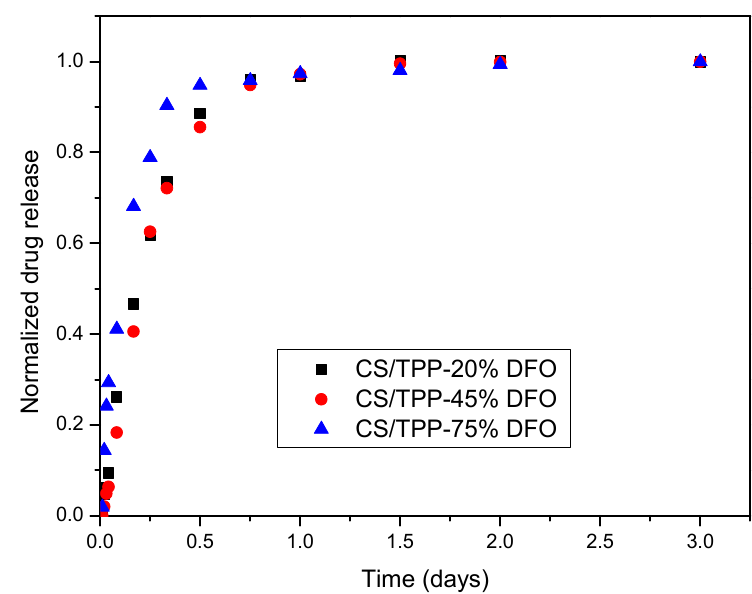
Figure 9. Normalized drug release data for three types of nanoparticles.